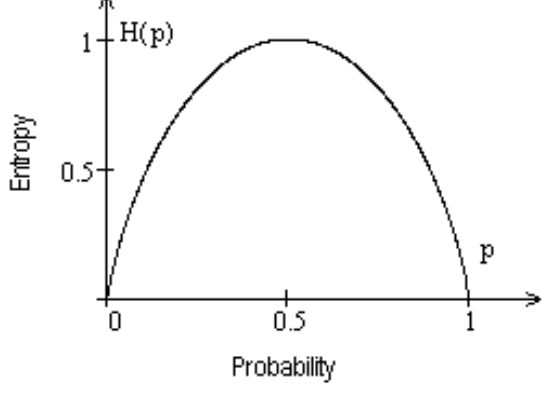
Figure 4. Entropy Figure 4. Entropy diagram.